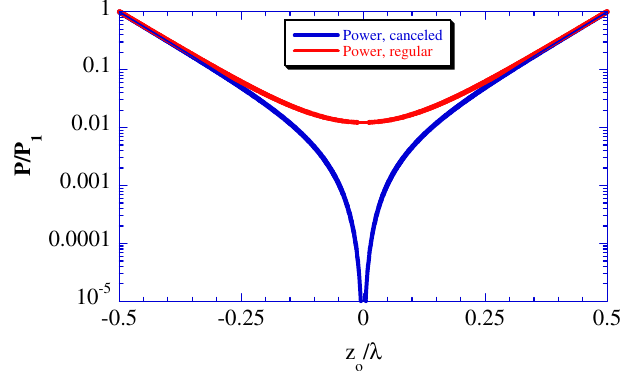
FIG. 5. (Color) Power distribution inside a unit-length tube. (a) Blue curve—the power of canceling evanescent waves with ð 2 n þ 1 Þ (cid:2) -phase difference, and (b) red curve—the phased evanescent waves with a 2 n(cid:2) phase